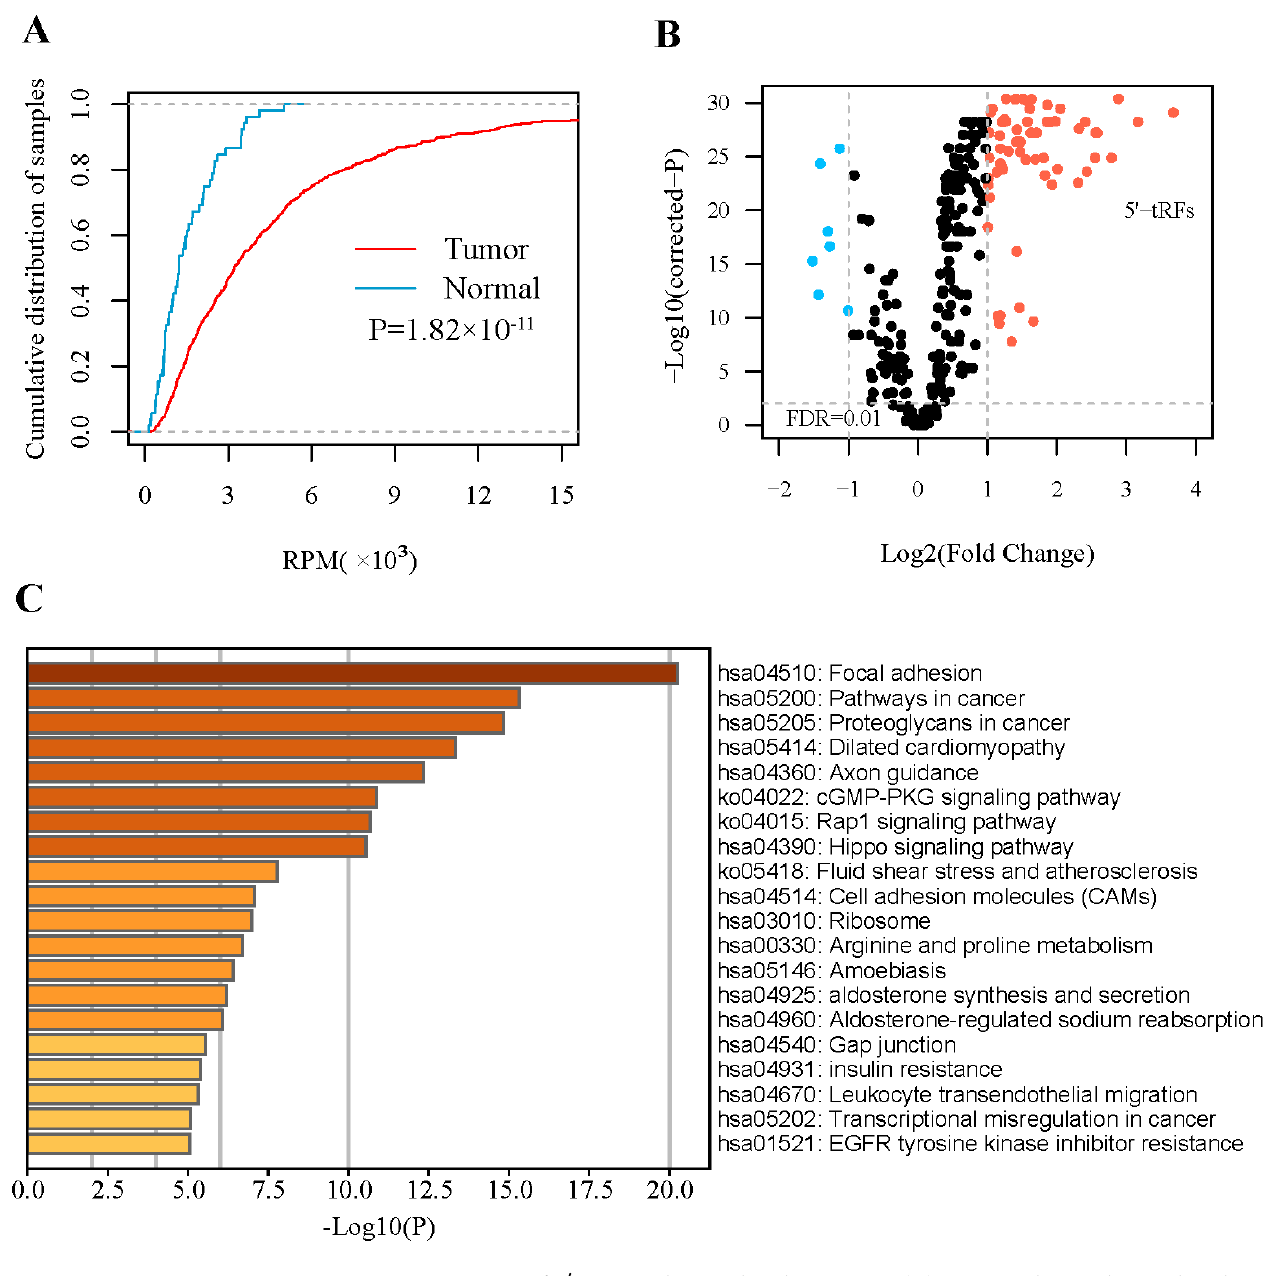
Figure 1. Expression of 5 (cid:48) -tRFs is dysregulated in PRAD. ( A ) Empirical cumulative distribution of the overall 5 (cid:48) -tRF in PRAD tumors and adjacent normal tissues. ( B ) Volcano plot showing − log10 ( p value) vs. log2 (fold change) of 5 (cid:48) -tRFs between PRAD tumors and adjacent normal tissues. p values represent significance level of the difference in 5 (cid:48) -tRF expression between PRAD tumors and adjacent normal tissues. ( C ) Pathways enriched for mRNA genes co-expressed with significantly dysregulated 5 (cid:48) -tRFs.